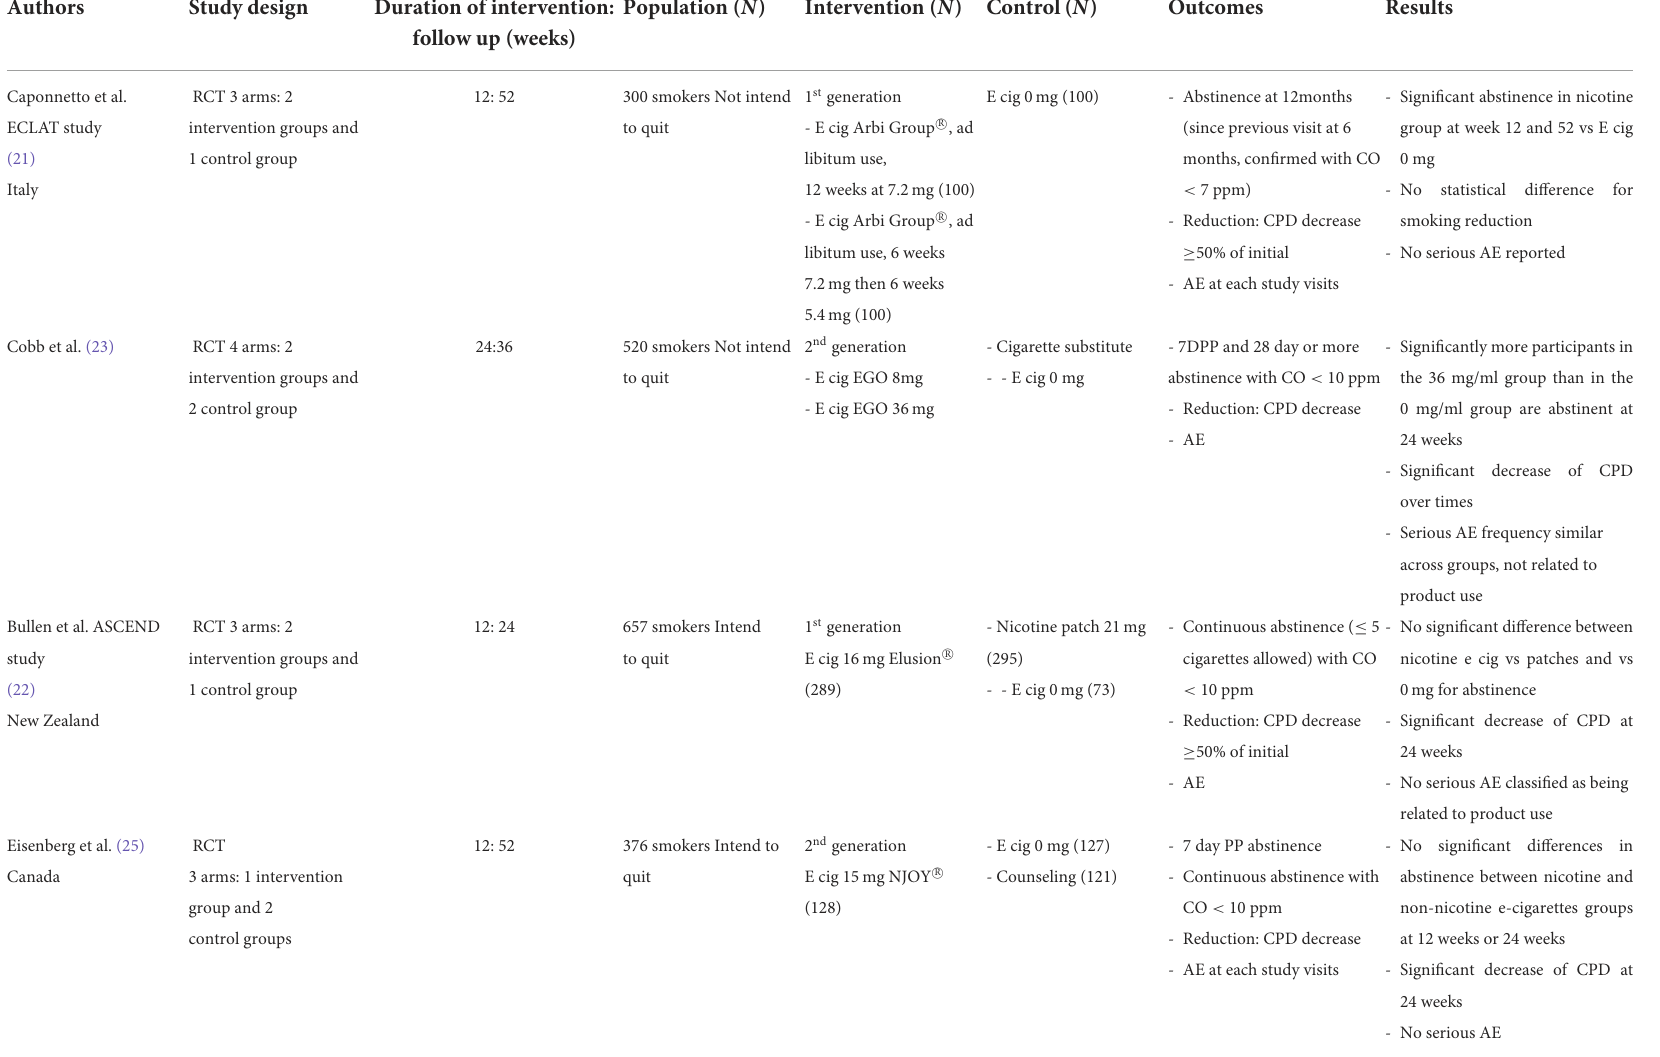
TABLE 1 Characteristics of included